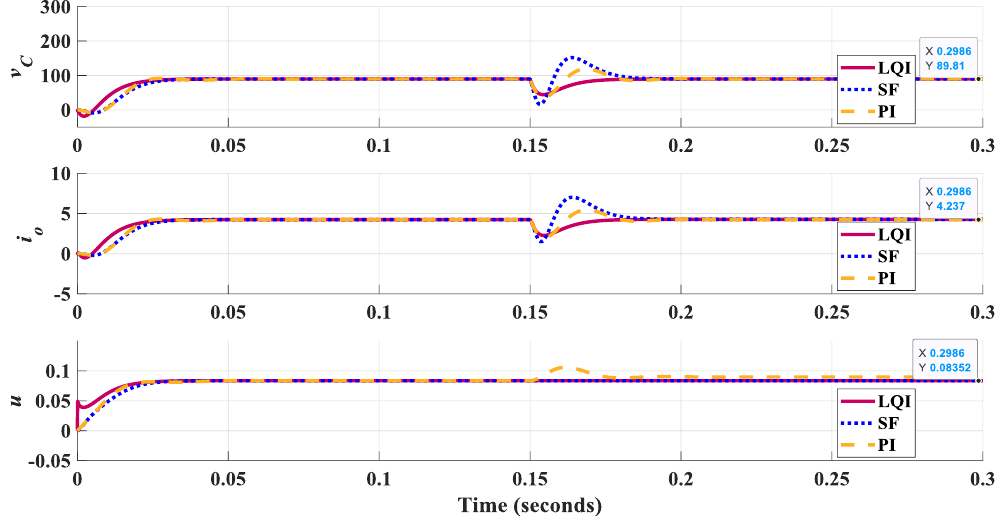
Figure 7. Simulation results for a load disturbance of 4 A under nominal condition ( D = 0.4374 and R o = 27).